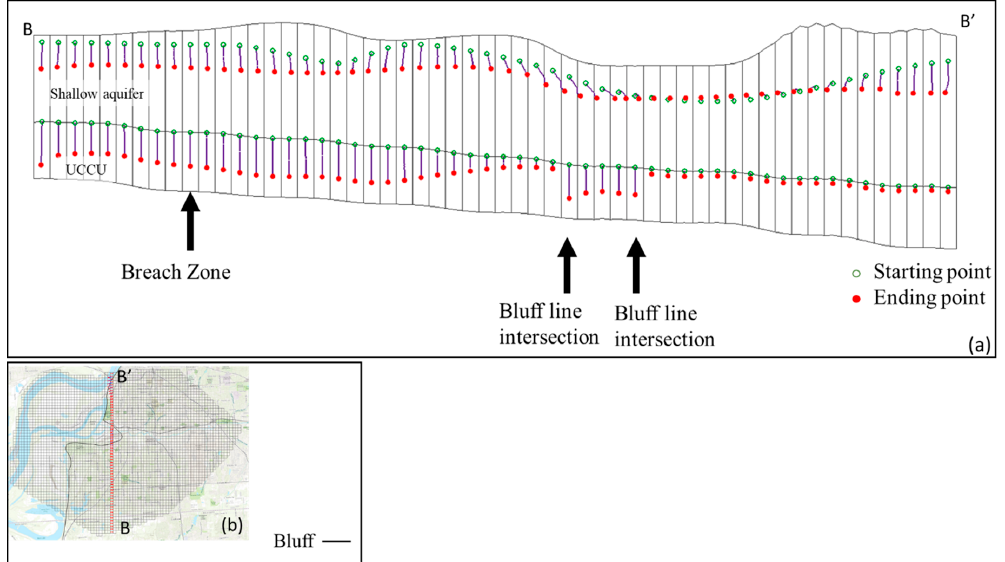
Figure 13. B–B’ cross section of the shallow aquifer and the UCCU, showing particle tracking results. ( a ) shows cross-section of the shallow aquifer and the UCCU along B–B’. ( b ) shows the plan view of the cross section. Particles are placed on top of the groundwater in the shallow aquifer, and on top of the UCCU, in 2005 (green mark). Forward particle tracking shows the transport of the particles within the layers (blue line), and the position of each particle at the end of the simulation in 2015 (red mark).